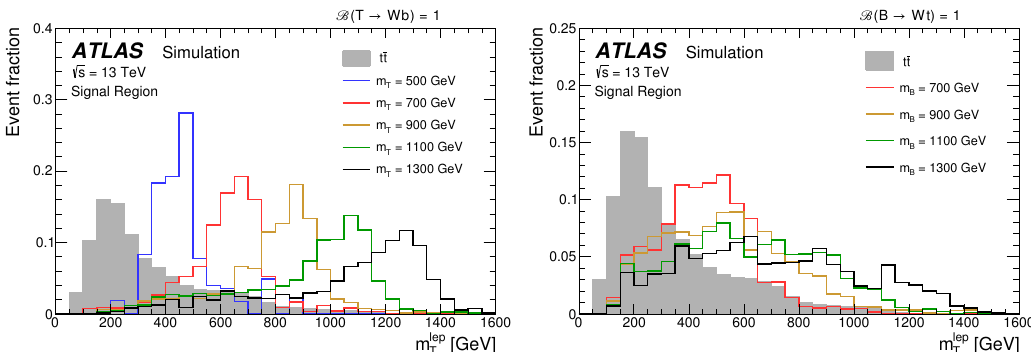
Figure 1 . The reconstructed leptonic T quark mass in the signal region is shown for the t (cid:22) t background and a few signal mass points, for the signal models B ( T ! Wb ) = 1 (left) and for the signal models B ( B ! Wt ) = 1 (right). In both (cid:12)gures, the distributions are normalised to unity for comparison of the relative shapes at each mass point. Due to the limited Monte Carlo sample size, the t (cid:22) t distribution has been